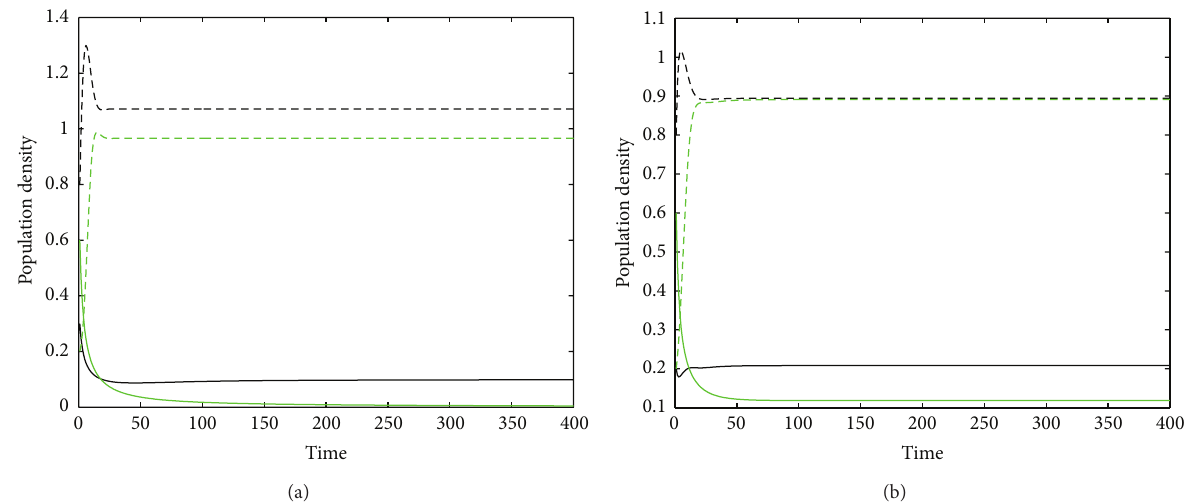
Figure 4: The dynamics of models (38) and (39) subject to (41). (a) is the dynamics of (38). It is observed that the predator in patch 1 will go to extinction. (b) is the dynamics of (39). It is observed that the predator in patch 1 is permanent now due to the dispersal corridors, and (39), as a whole, is permanent. The black solid (dotted) line is the population variation of the prey in patch 1 (patch 2). The green solid (dotted) line is the population variation of the predator in patch 1 (patch 2). Table 2: Net reproduction rates and the permanence of model (39) under different dispersal rates. Dispersal